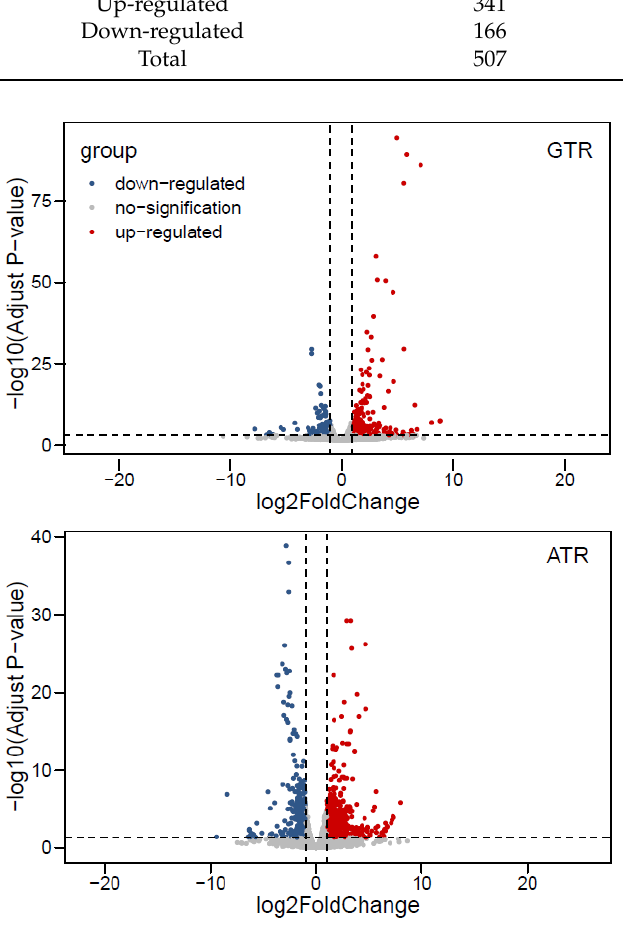
Figure 4. Volcano plot of DEGs after GTR and ATR. Every dot represents one gene; the red dots represent significantly up-regulated genes, the blue dots represent significantly down-regulated genes and the grey dots represent genes which have not reached the differential expression level.